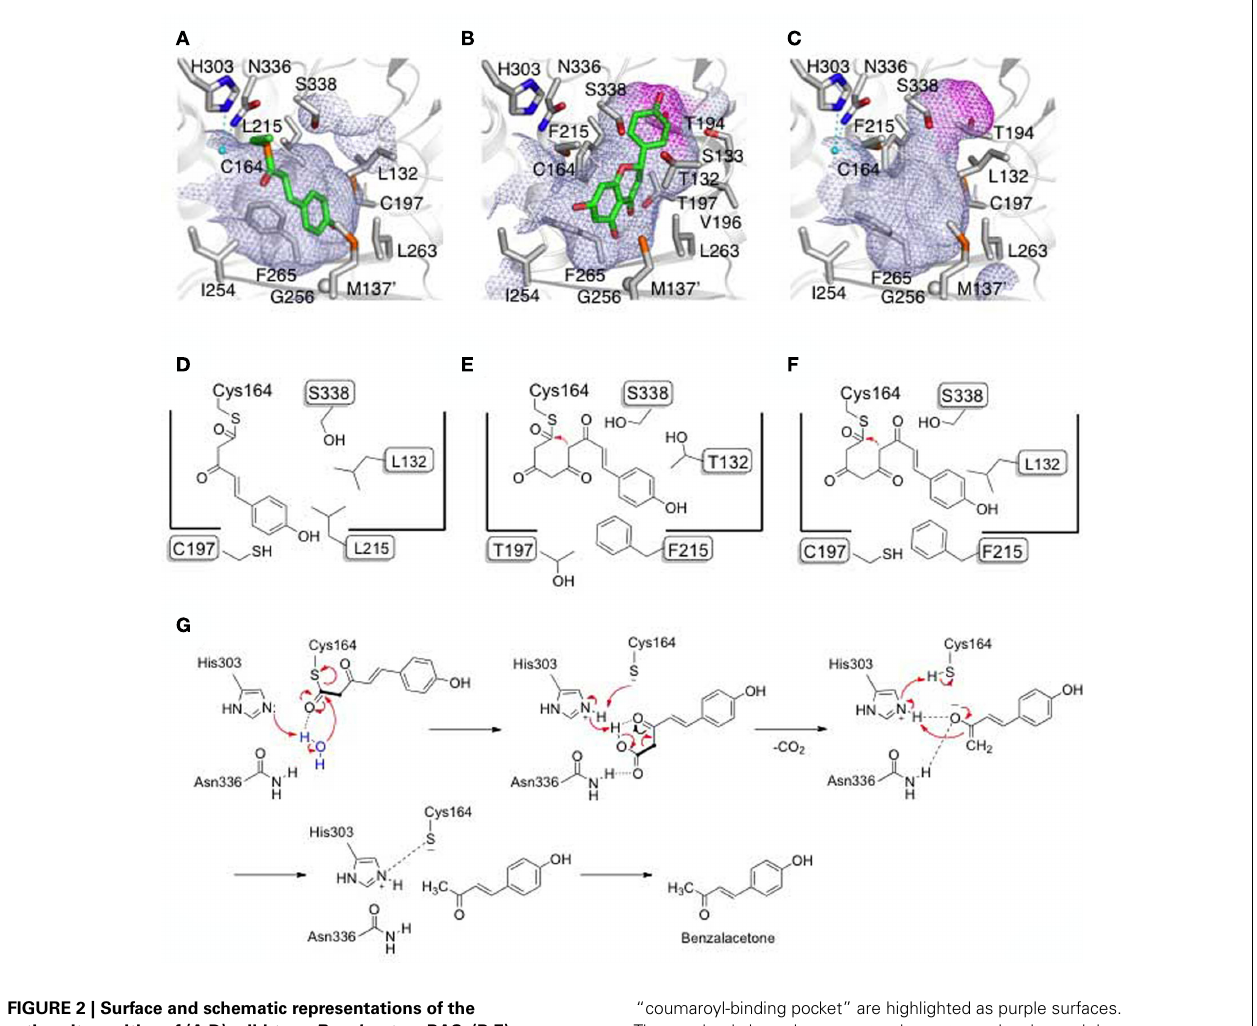
FIGURE 2 | Surface and schematic representations of the active-site cavities of (A,D) wild-type R. palmatum BAS, (B,E) M. sativa CHS, and (C,F) the R. palmatum BAS I207L/L208F mutant (numbering in Rp BAS). The bottoms of the